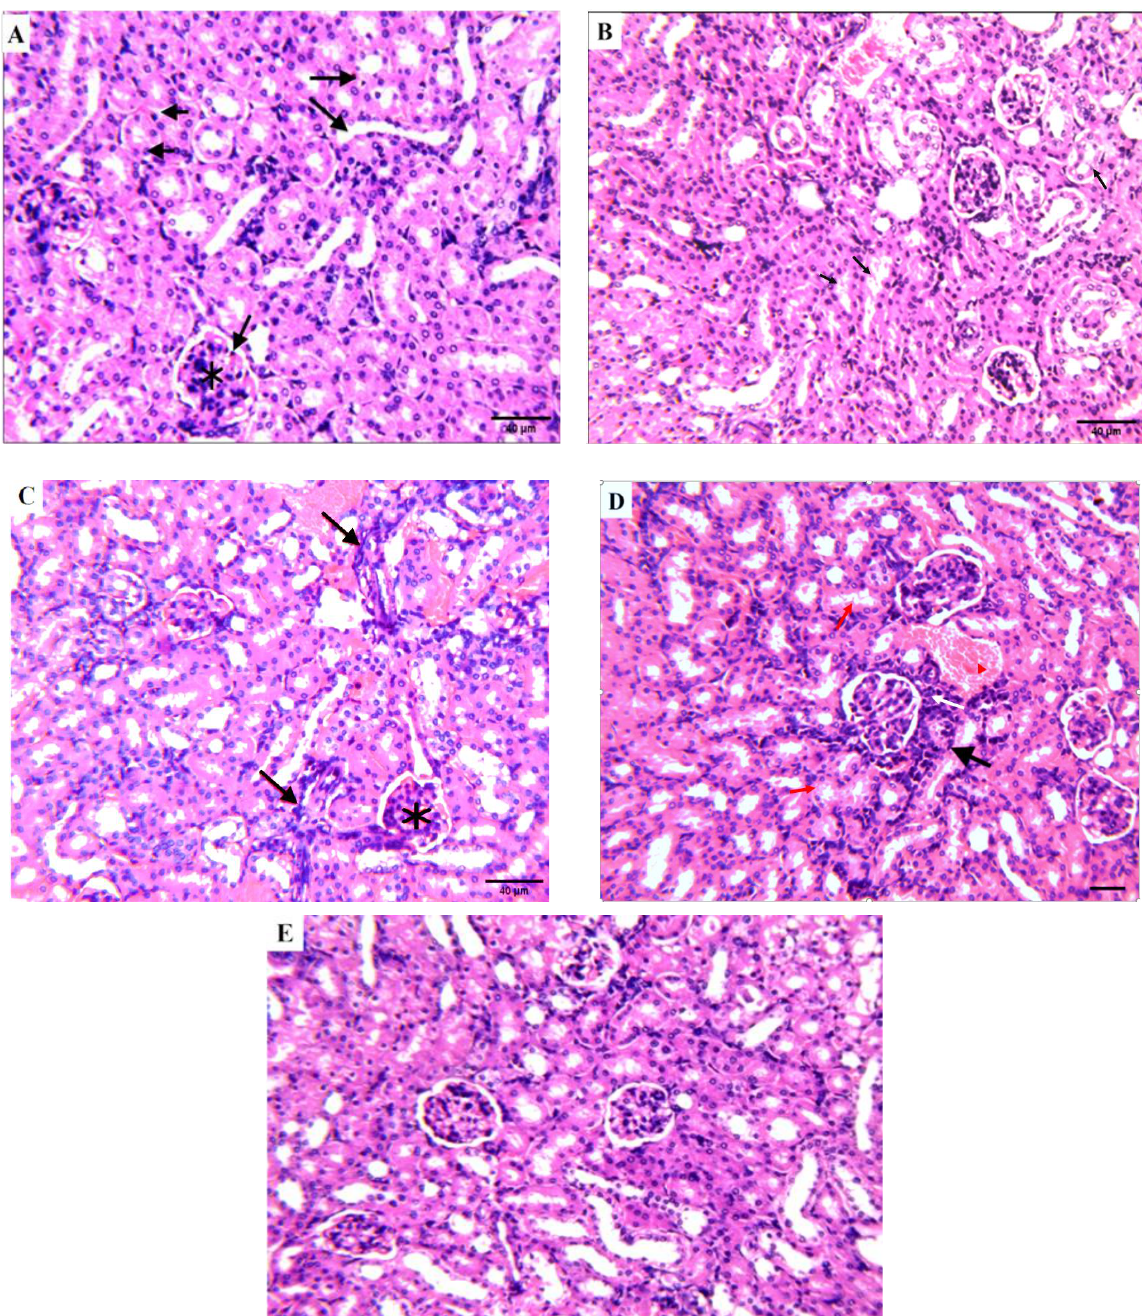
Figure 9. Effect of compound 4 on the kidney tissue of SEC-bearing mice. ( A ) Normal control group shows intact renal corpuscle of the glomerulus (asterisk) and bowman ’ s capsule with urinary space (arrowhead) surrounded with proximal (short arrows) and distal convoluted tubules (long arrows). ( B ) Normal group treated with compound 4 shows very few tubules and evidence of acute tubular injury (black arrows). ( C ) SEC control group mice show inflammatory infiltration in interstitial spaces (arrows), renal corpuscles show congestion and hypercellularity (asterisk), glomerular and intratubular hyperemia. ( D ) SEC mice treated with 5-FU: few tubules show evidence of renal acute tubular injury ATI (red arrows), focal area of hemorrhage (red arrowhead), and interstitial inflam- mation (white arrow). ( E ) SEC mice treated with compound 4 (H&E stains, magnification × 400). Quantification data of the H&E analysis of kidney are supported in Supplementary Table S2).